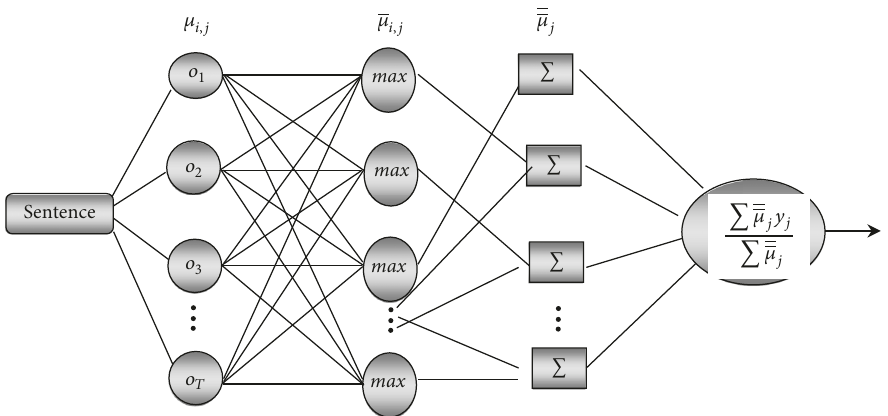
Figure 1: General description of FCS.